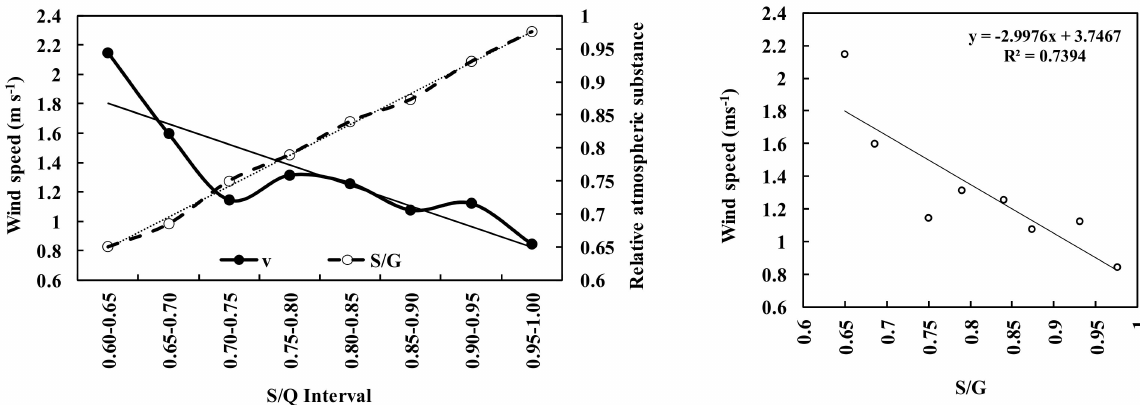
Figure 10. Monthly wind speed and monthly atmospheric substance for the x axis using the S/G interval at 0.05 ranging from 0.60 to 1.00 ( left ) and their scatter plot ( right ) during June 2013 to December